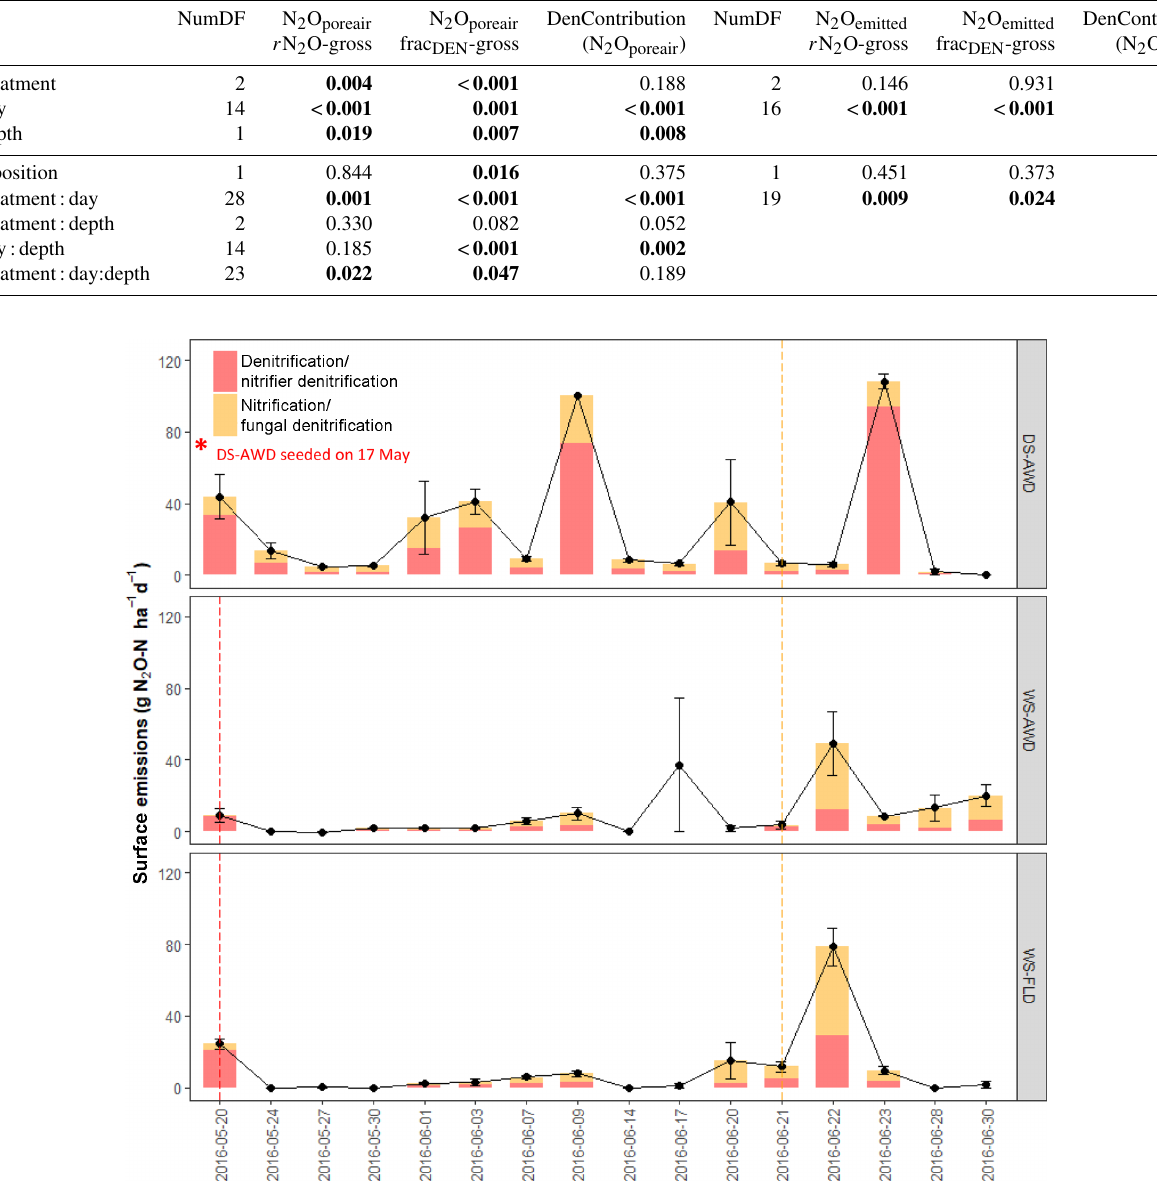
Figure 6. Estimated contribution of denitrification/nitrifier denitrification and nitrification/fungal denitrification to N 2 O surface emissions in the three water management treatments (WS-FLD: water-seeding + conventional flooding; WS-AWD: water-seeding + alternate wetting and drying; DS-AWD: direct dry seeding + alternate wetting and drying). Estimates were derived from the mean of open and closed dynamics in a two end-member mixing model using δ 18 O-N 2 O and SP values. Red and orange dashed vertical lines represent the date of seeding and fertilization in each treatment,